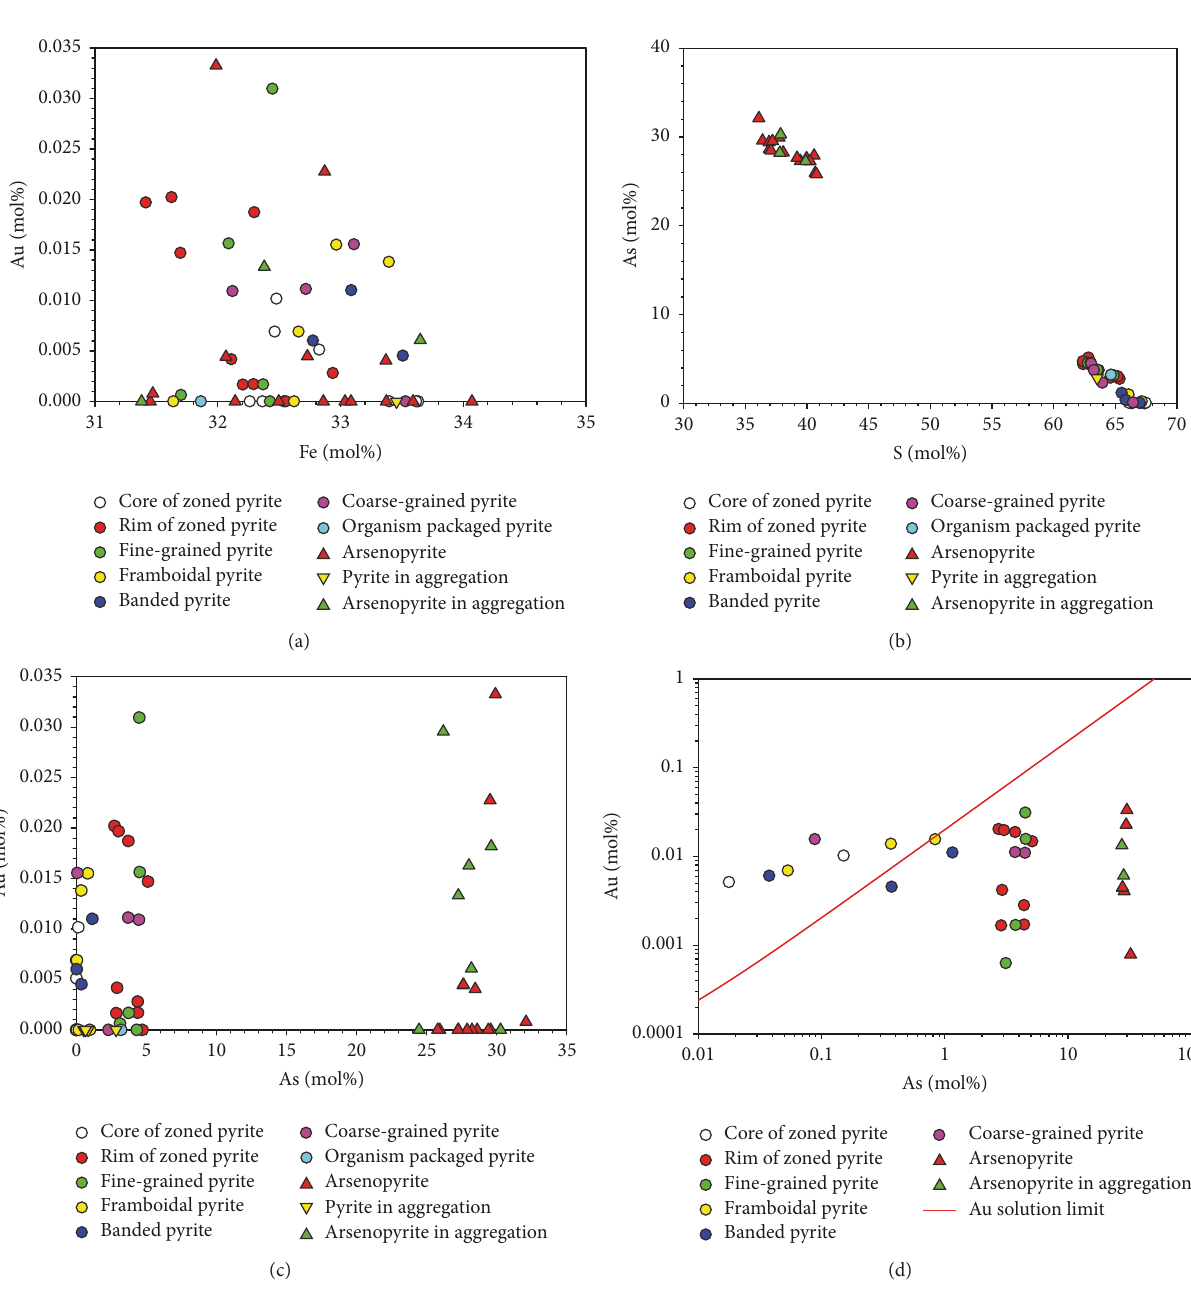
Figure 7: Relationships between selected elements in the arsenian pyrite and arsenopyrite, including (a) Au-Fe, (b) As-S, (c) Au-As, and (d) lgAu-lgAs. The red line in (d) denotes the solubility limit of Au in arsenian pyrite. The equation of the curve is 𝐶 Au = 0.02 𝐶 As + 4 × 10 −5